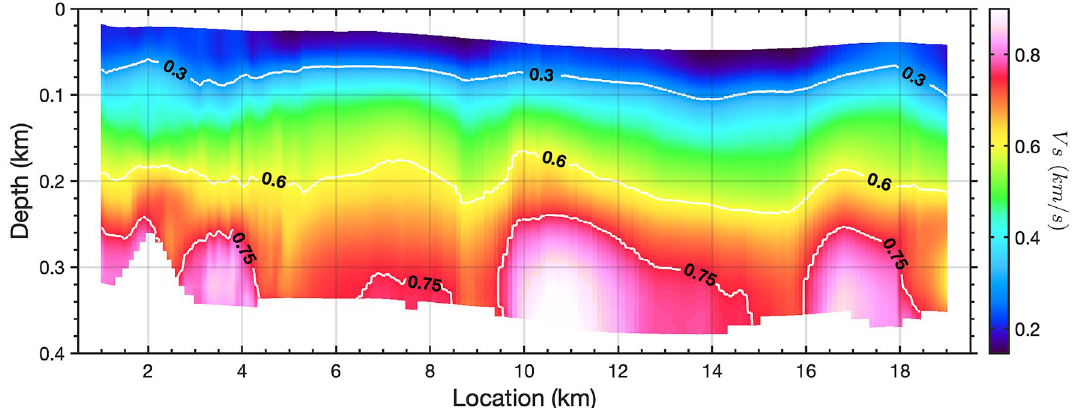
Figure 6. 2D V s profile constructed from 1D V s models obtained from 181 sub-arrays of 1 km length. A 1% -width smoothing factor has been applied on the V s image along the profile. Shear-wave velocity model contours are shown in units of km/s.